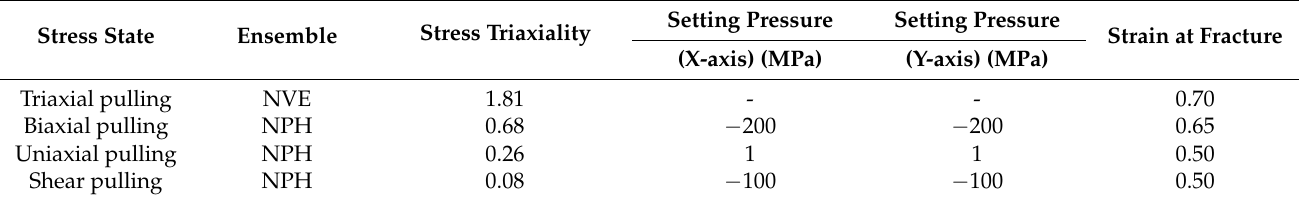
Table 1. Simulation conditions for fracture